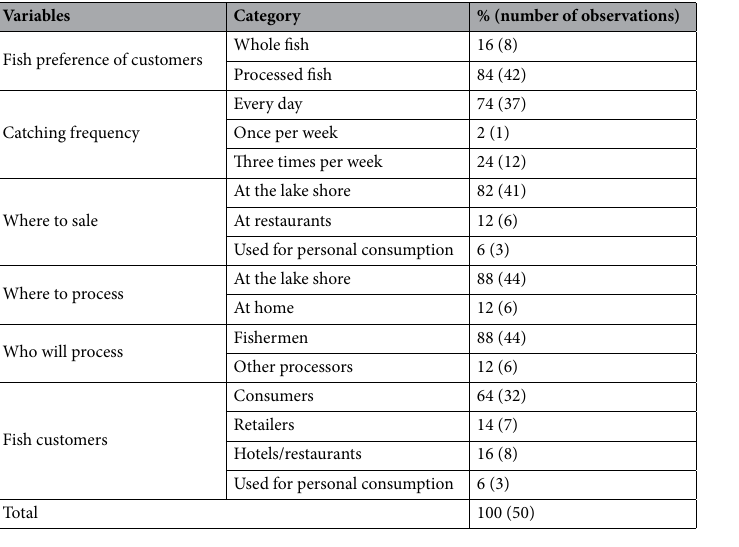
Table 2. Fish processing, transportation, and handling practices by the fishermen (n = 50) in east Shewa zone,